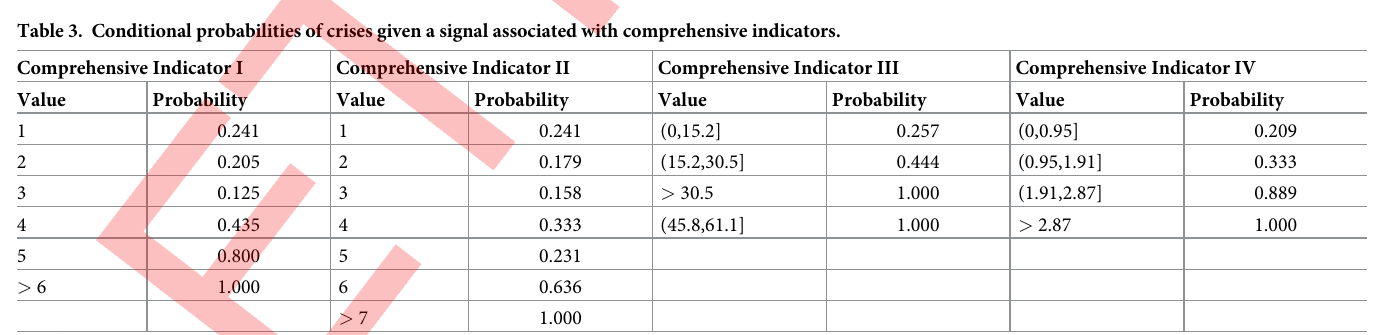
Table 3. Conditional probabilities of crises given a signal associated with comprehensive